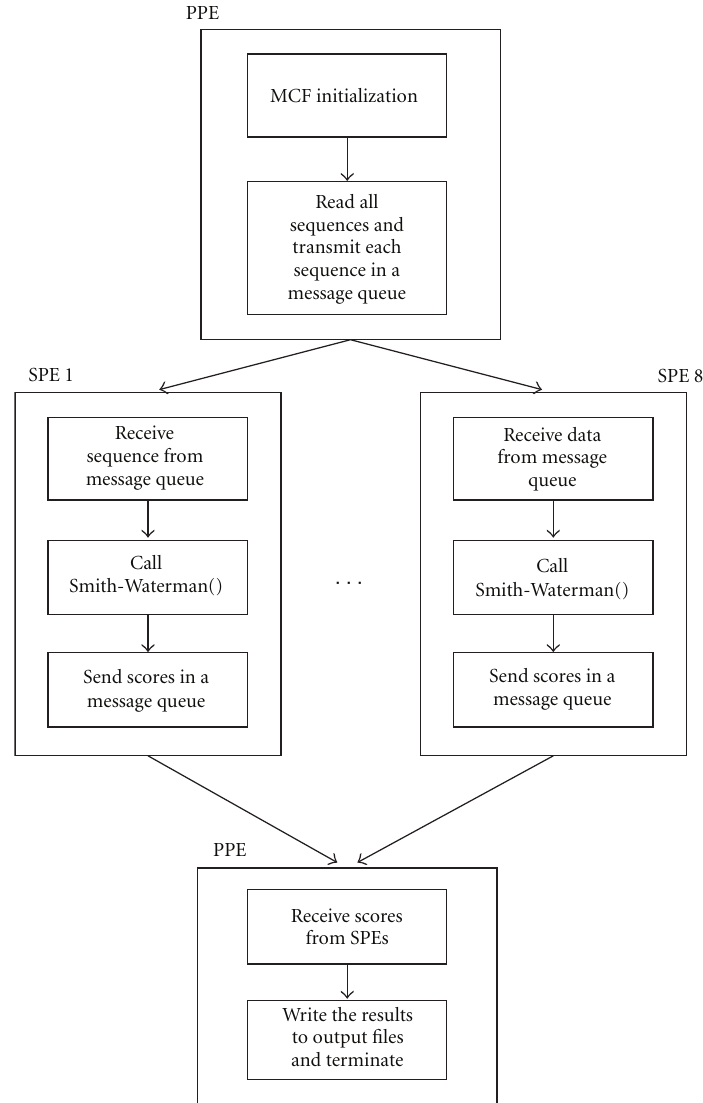
Figure 11: The parallel code flow of Smith-Waterman algorithm on Cell BE. The PPE transmits data to SPEs via one message queue and receives the results from SPEs by